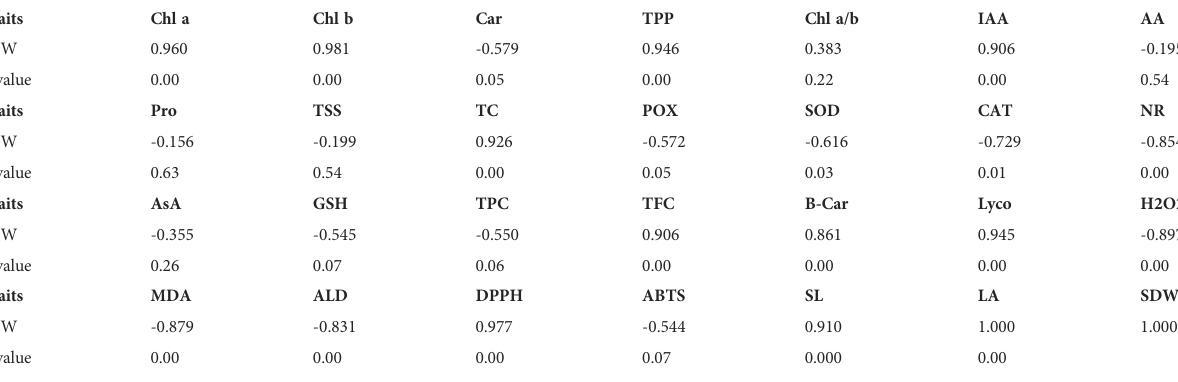
TABLE 8 Pearson ’ s correlation coef fi cients among shoot dry weight and all measured traits of whaet plants foliar sprayed with 4 levels of aspartic acid grown under three levels of 0, 30, or 60 mM NaCl salt stress for 60 days (n = 12). Traits